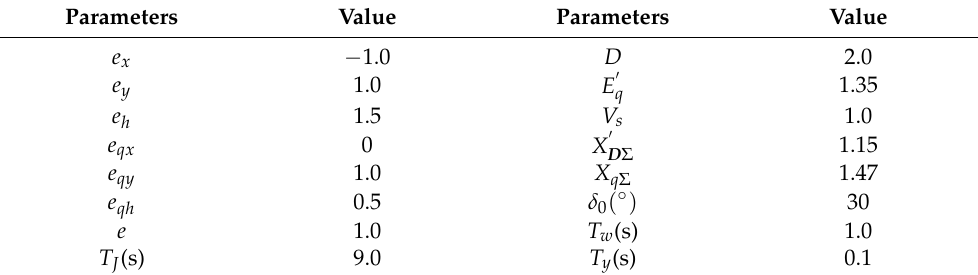
Table 2. Parameters of